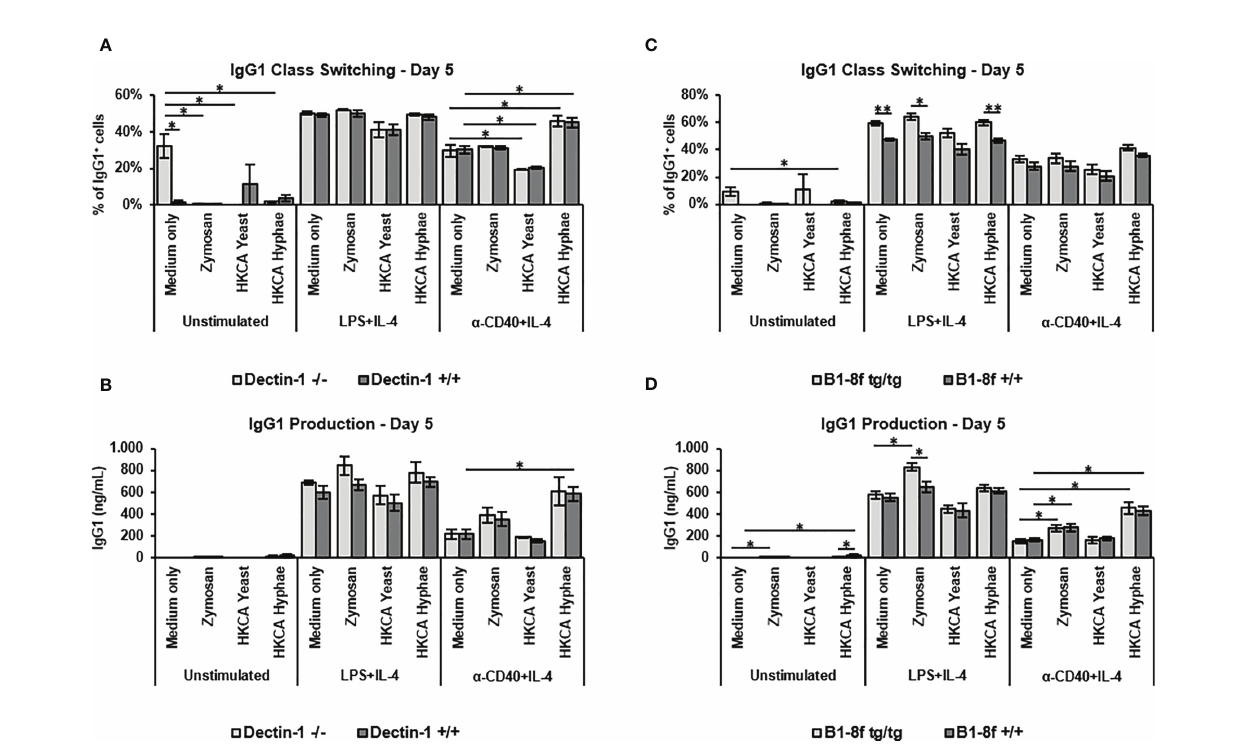
FIGURE 3 | Increased antibody production upon stimulation with Zymosan or HKCA hyphae is not dependent on dectin-1 or speci fi c B cell receptor recognition. Splenic B cells from Dectin-1 -/- and Dectin-1 +/+ mice (A, B) and B1-8f tg/tg and B1-8f +/+ mice (C, D) were cultured unstimulated or stimulated with LPS+IL-4 or anti- CD40+IL-4 in the presence of Zymosan, HKCA yeast or HKCA hyphae. After 5 days of culture, the percentage of IgG1-positive cells within live B cells was measured by fl ow cytometry (A, C) , and the concentration of secreted IgG1 was measured by ELISA (B, D) . Data represent mean ± SEM of 3 mice, with triplicate measurements performed for each mouse. *p < 0.05, **p <